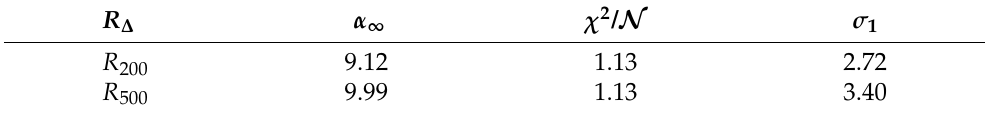
Table 2. Best fit values for α estimated for the modified cluster mass in Equation